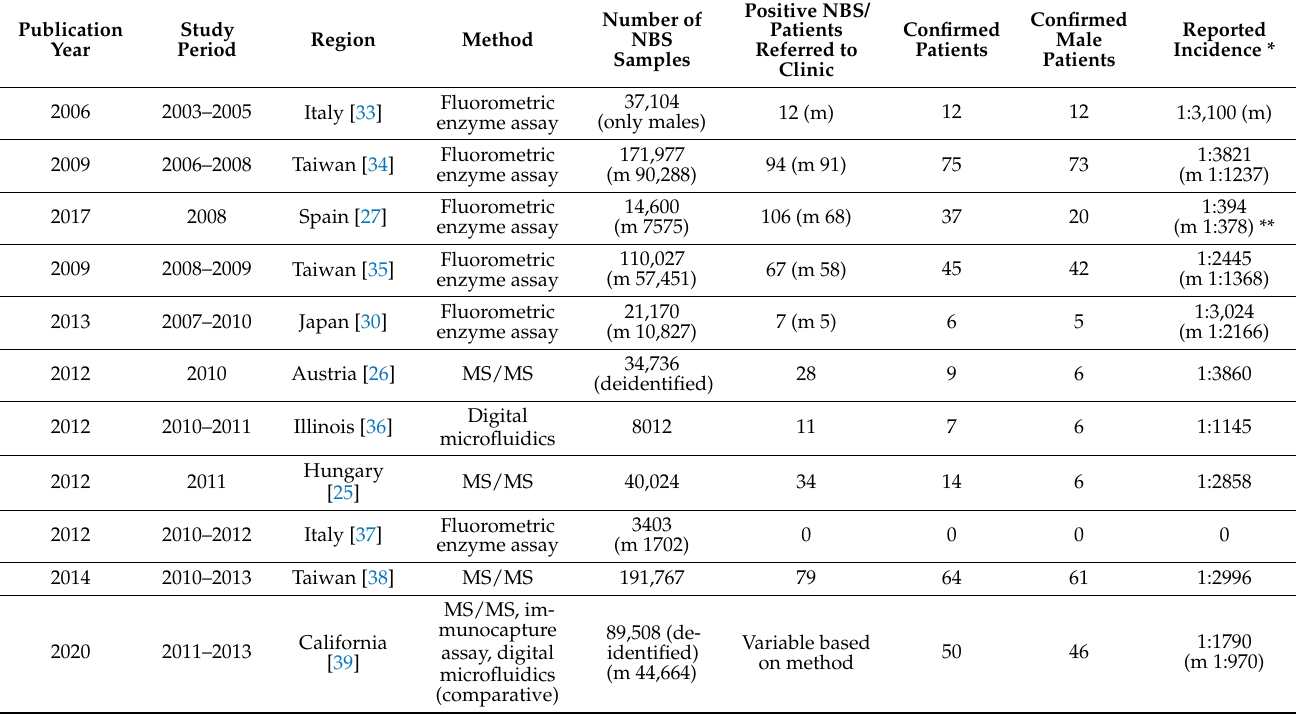
Table 1. Summary of the methods and results from pilot and regular screening programs for Fabry disease